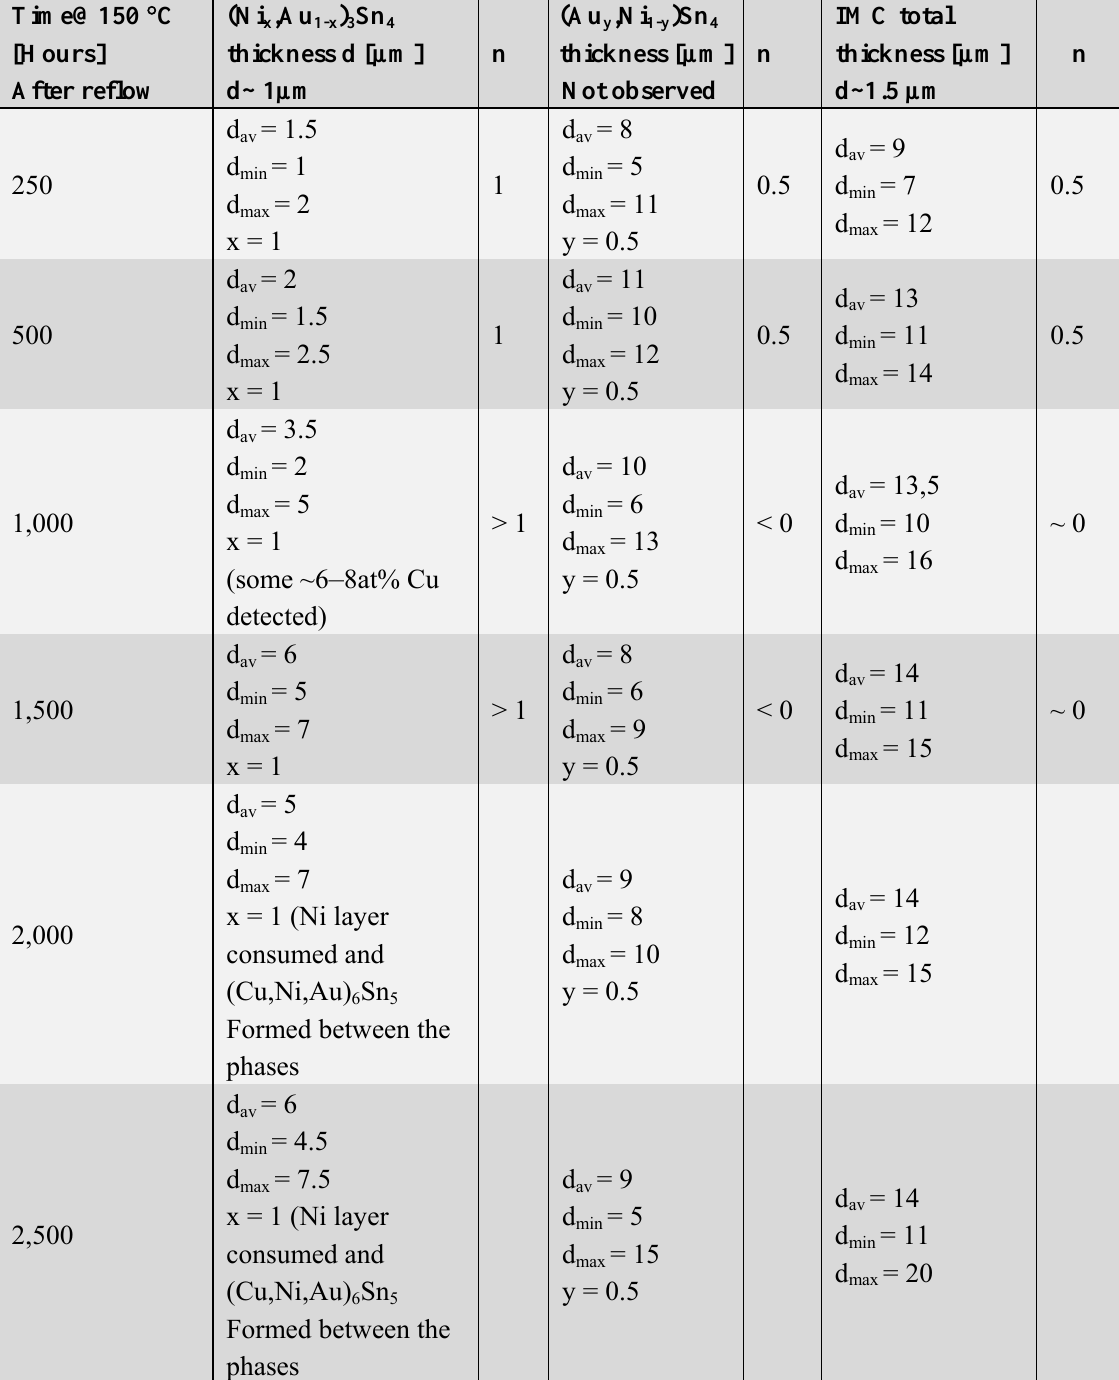
Table 2. Minimum (d ), maximum (d ) and average thickness (d min max compositions as well as the growth exponents (n) determined by the regression analysis for the phases formed in (SnAg)/Ni/Au reaction